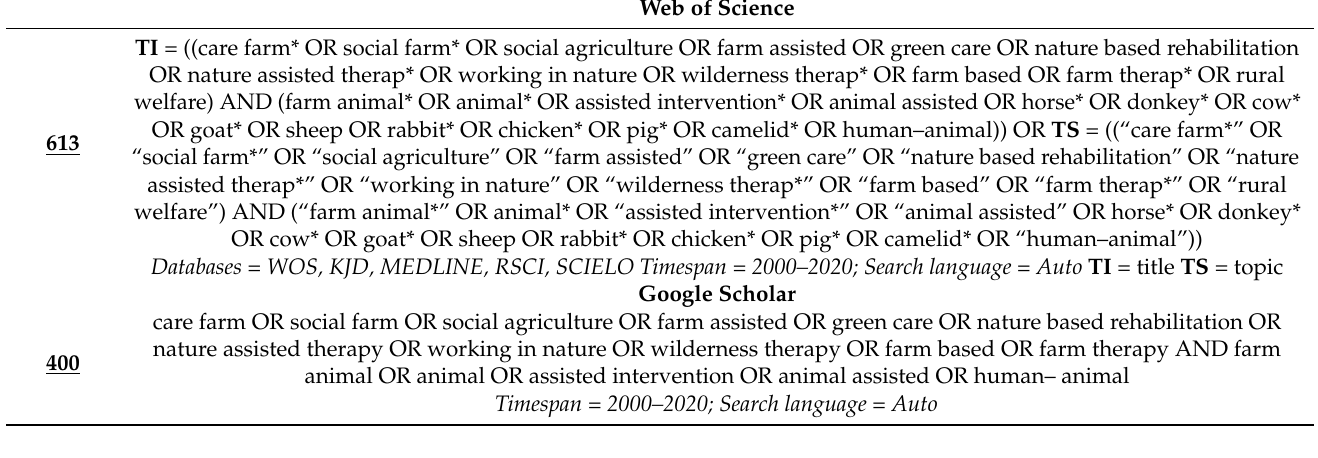
Table 1. Search strings in Web of Science and Google